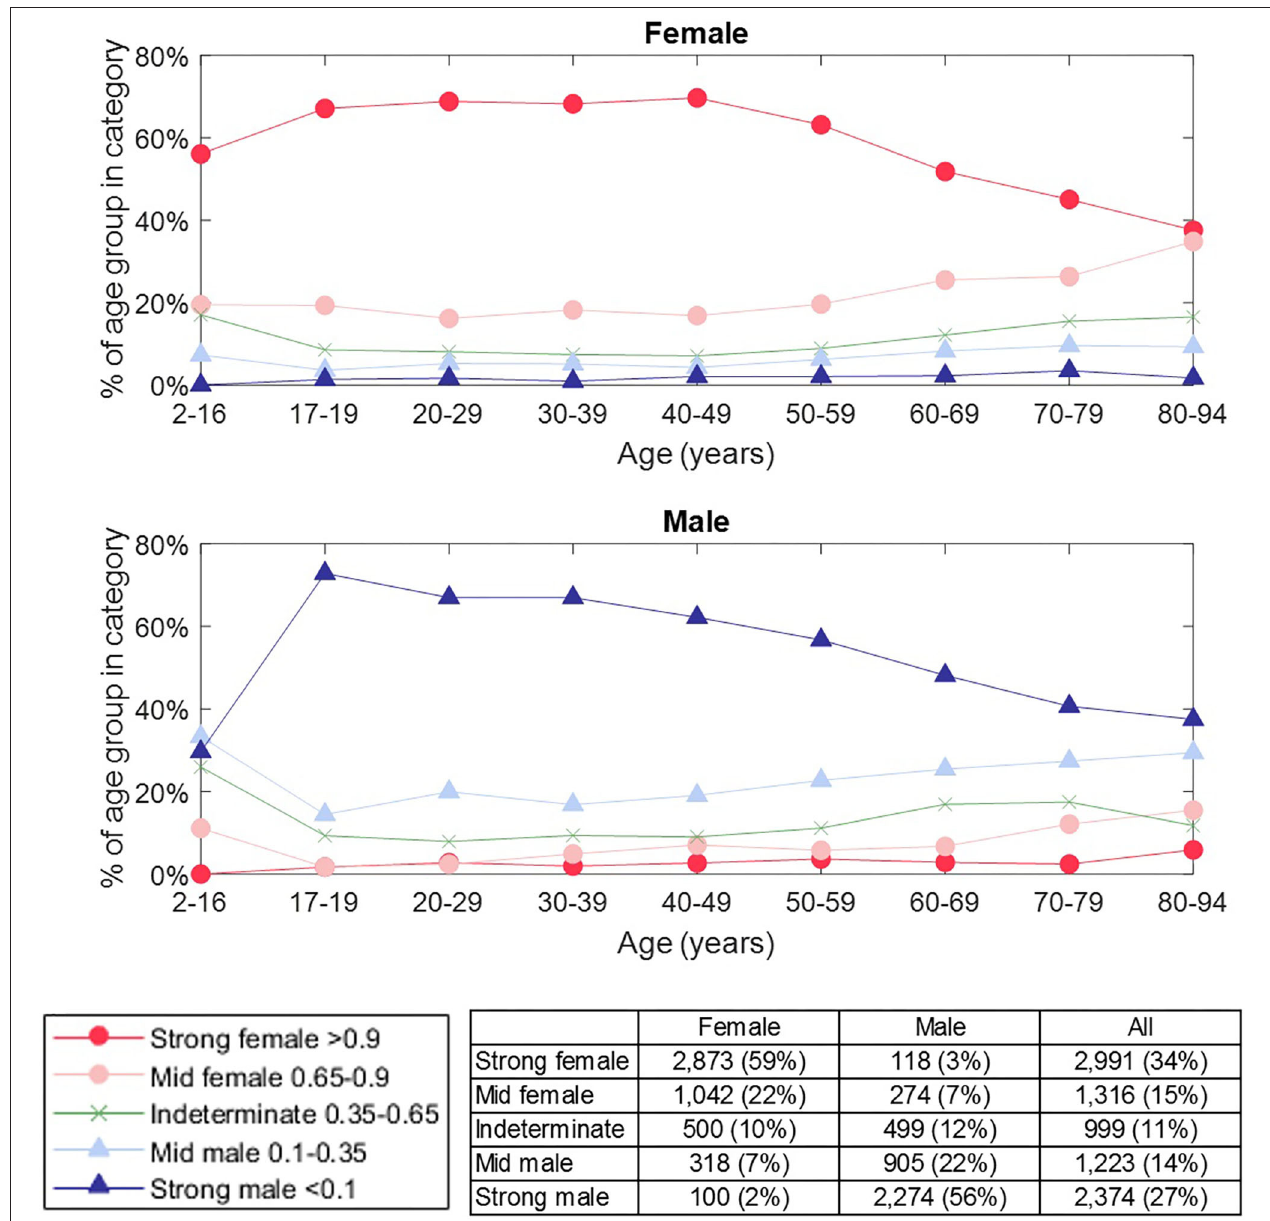
FIGURE 8 | Prevalence of classification category by sex and age group. The classification category is defined by the classification score for a subject, as indicated in the legend. The number of female / male subjects in each category is shown in the table. The proportion of “strong male” classifications peaked in young adults and then declined, whereas the proportion of “strong female” classification did not begin to decline until around 50 years. Subjects were more likely to be classified as “indeterminate” than to have a “mid” or “strong” score of the opposite sex (other than for the oldest male category), which supported that the score can be related to our confidence in